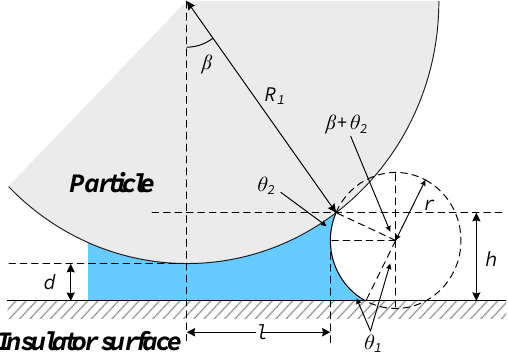
Figure 4. Contact model between particle and surface.